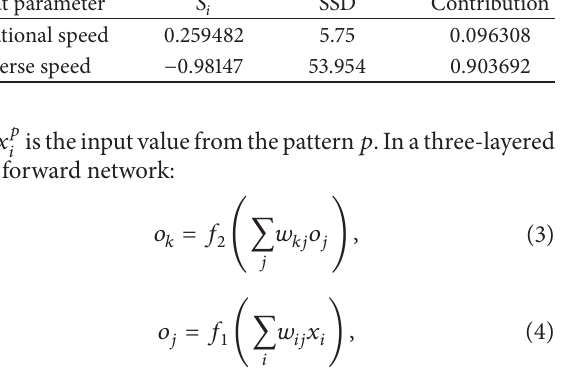
Figure 7: Contribution of variables used in the ANN model for tensile shear force, by the Profile algorithm with scale of